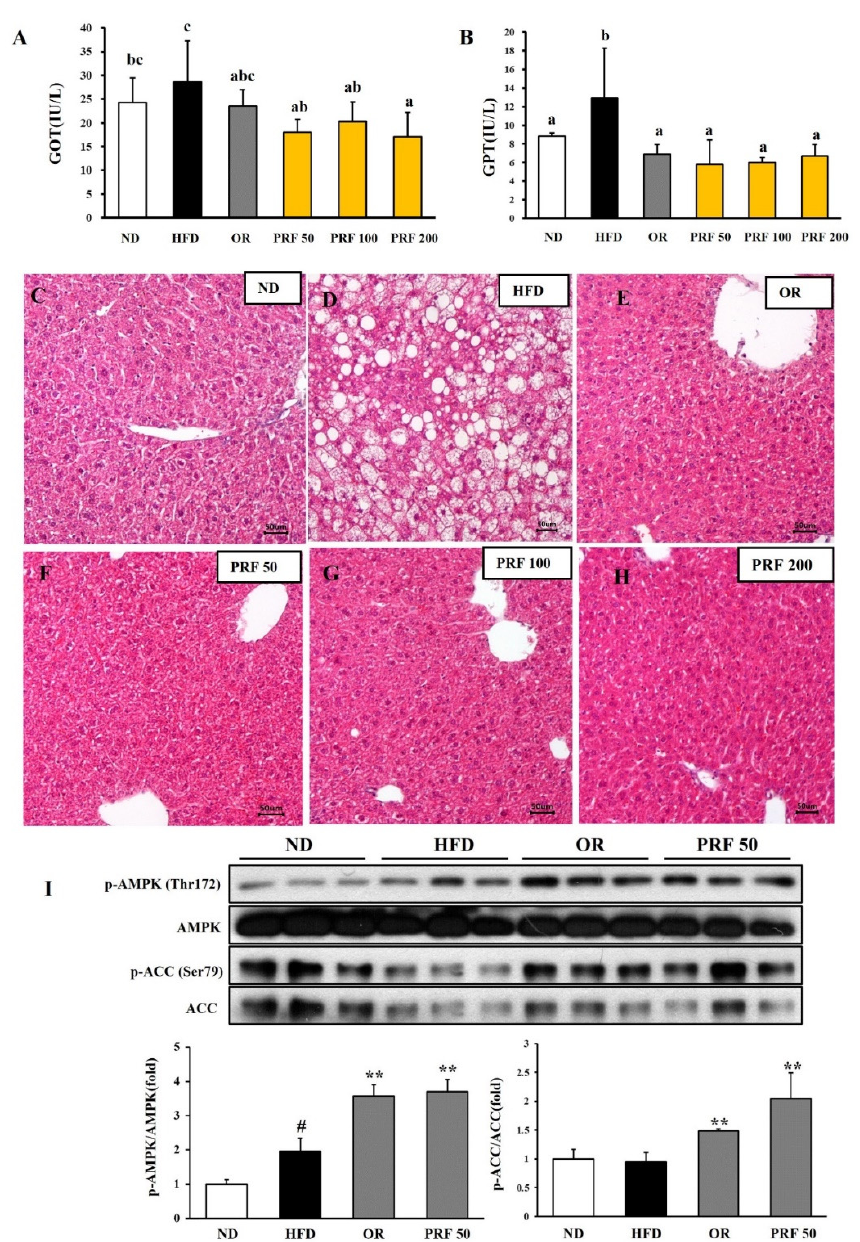
Figure 6. Effect of PRF on liver function in HFD-induced obese mice. ( A ) GOT levels; ( B ) GPT levels. The results are expressed as the means ± SDs ( n = 7). The values with different letters (a–c) are significantly different ( p < 0.05) from each other according to one-way ANOVA and Duncan’s multiple-range test. The liver sections for ND ( C ), HFD ( D ), OR ( E ), PRF 50 ( F ), PRF 100 ( G ), and PRF 200 ( H ) stained with H&E (200×). Scale bar = 50 µm. ( I ) Western blot of AMPK and ACC. The results are expressed as the means ± SDs ( n = 3; # p < 0.05 compared to ND; ** p < 0.01 compared to HFD). ND, normal diet; HFD, high-fat diet; OR, HFD + 15.6 mg of orlistat; PRF 50, PRF 100, and PRF 200, HFD + 50, 100, and 200 mg of PRF, respectively.